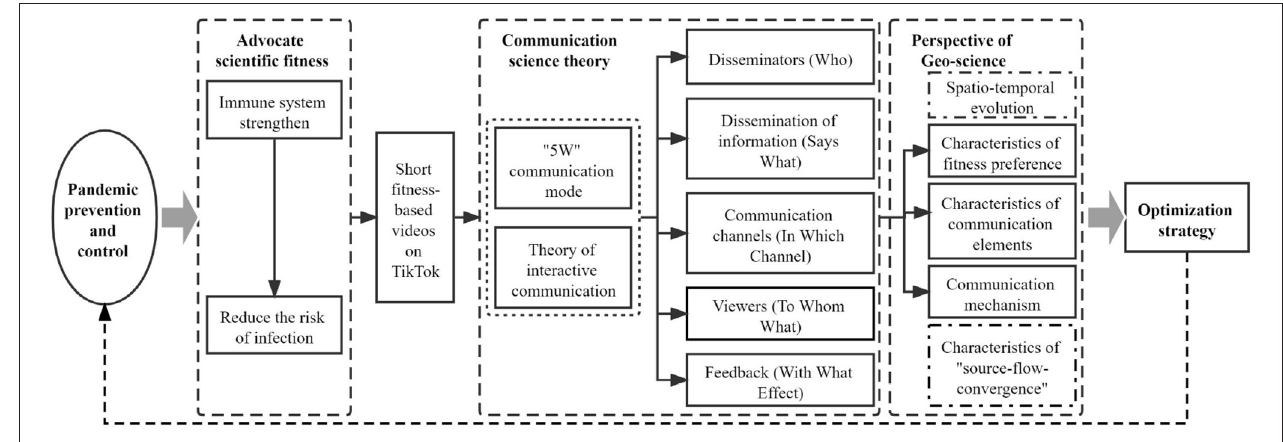
FIGURE 1 | Theoretical framework of short fitness videos on TikTok.